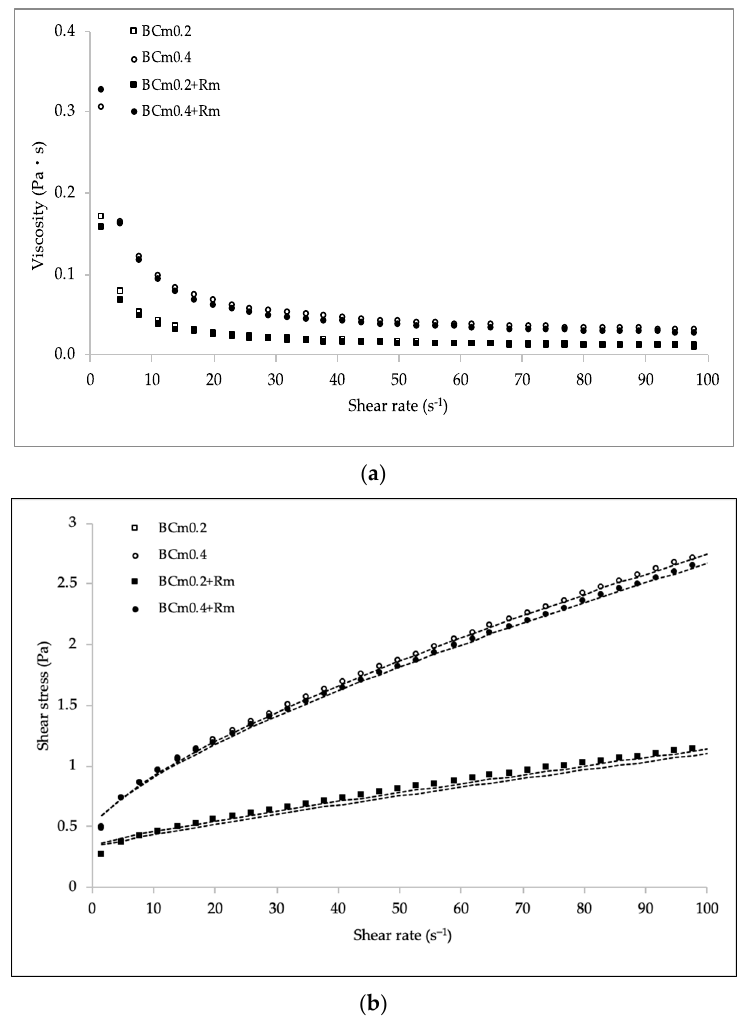
Figure 2. Viscosity ( a ) and steady shear rate flow ( b ) at 25 ◦ C for BCm-based filmogenic solutions with and without (-Rm) hydro-alcohol extract (HAE) of R. microphylla fruit at 2500 mg L − 1 . Lines ( ····· ) correspond to the Herschel–Bulkley